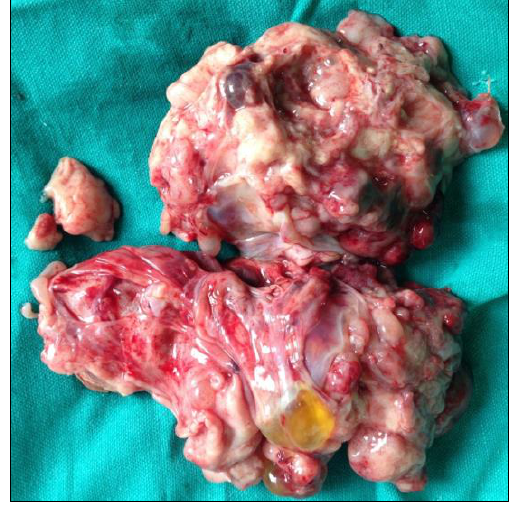
Figure 2: Cut surface of excised